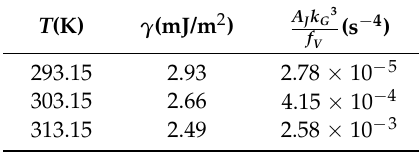
Figure 6. The induction time data of L-glycine at 293.15–313.15 K fitted to Equation (10) based on f V . Table 3. The fitted results of the induction time data to Equation (10) based on f V .